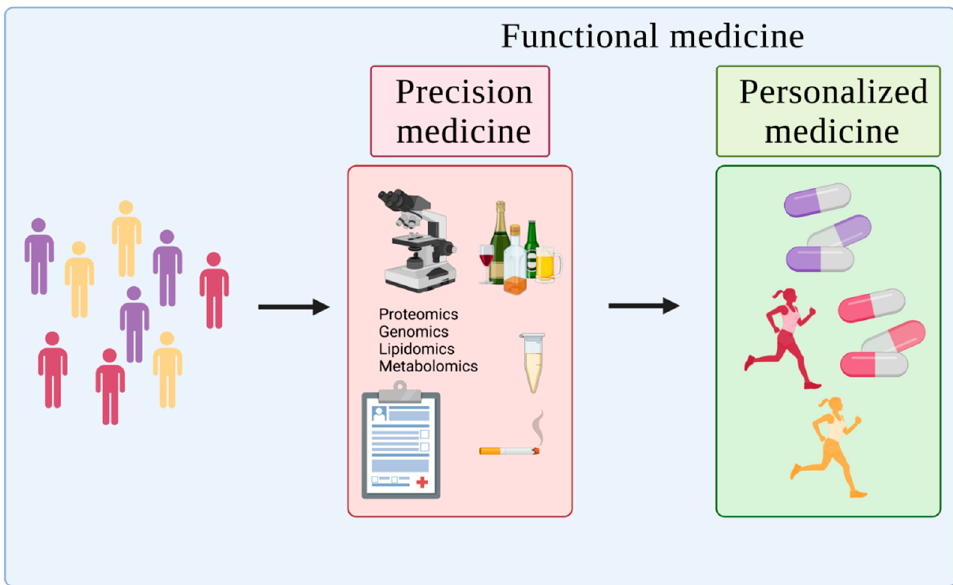
Figure 1. Precision vs. personalized vs. functional medicine. Precision medicine identifies differences in individuals, categorizing based on environmental, biological, and psychosocial factors. Personalized medicine takes these differences and implements preventions/treatments tailored to the individual. Functional medicine is an overarching term that seeks to encompass both precision and personalized medicine.